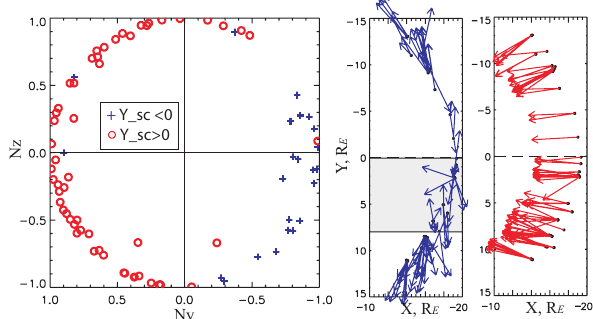
Fig. 18. Results of statistical analysis of 78 flapping current sheet crossings during July–October, 2001. Distributions of current sheet normals obtained by timing in (N y ,N z ) plane (left panel, samples from the dawn sector are marked by crosses and that from the dusk sector are marked by circles). Projections of the current sheet nor- mal velocity vectors (middle panel) and maximum variance mag- netic field (right panel) onto the (X,Y) GSM plane. (From Runov et al.,